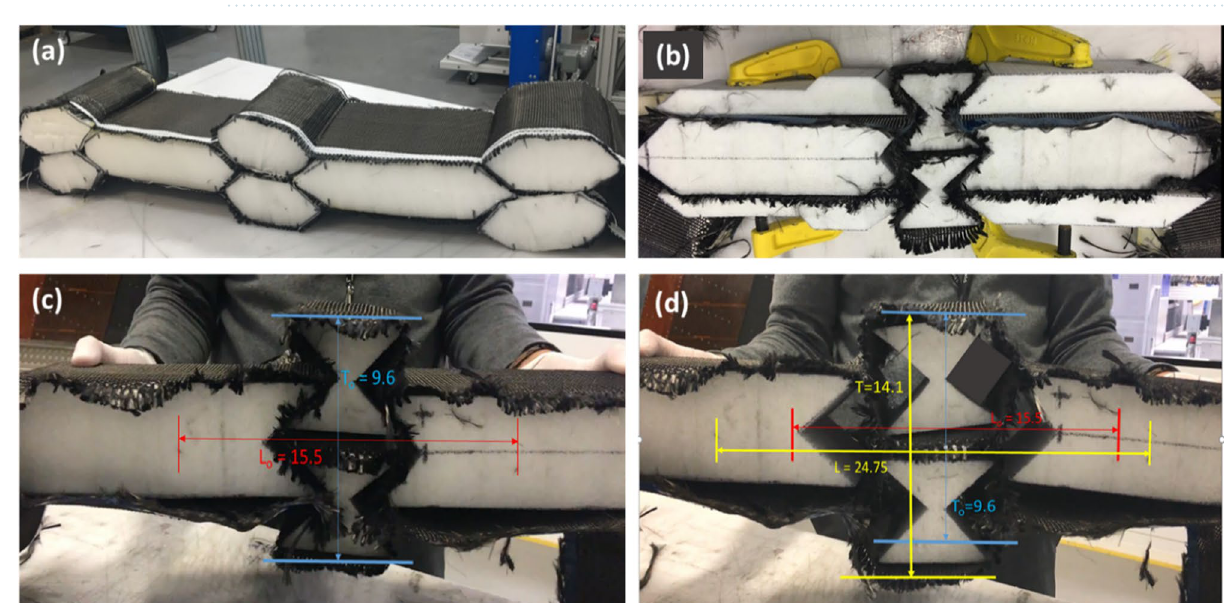
Figure 7. Samples of 3D woven honeycomb fabric.